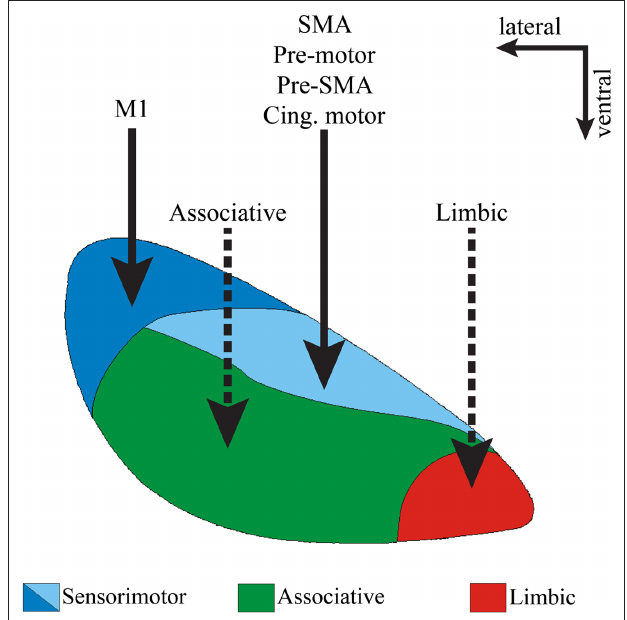
Figure 3 | Functional domains of the STN. Coronal view of the primate STN to illustrate the topographical organization of cortical afferents to various functional regions of the nucleus defined by their reciprocal connections with the globus pallidus and motor cortical areas. Solid lines indicate well established corticosubthalamic projections from motor and pre-motor cortices. Dotted lines indicate putative projections that need further confirmation. Abbreviations: